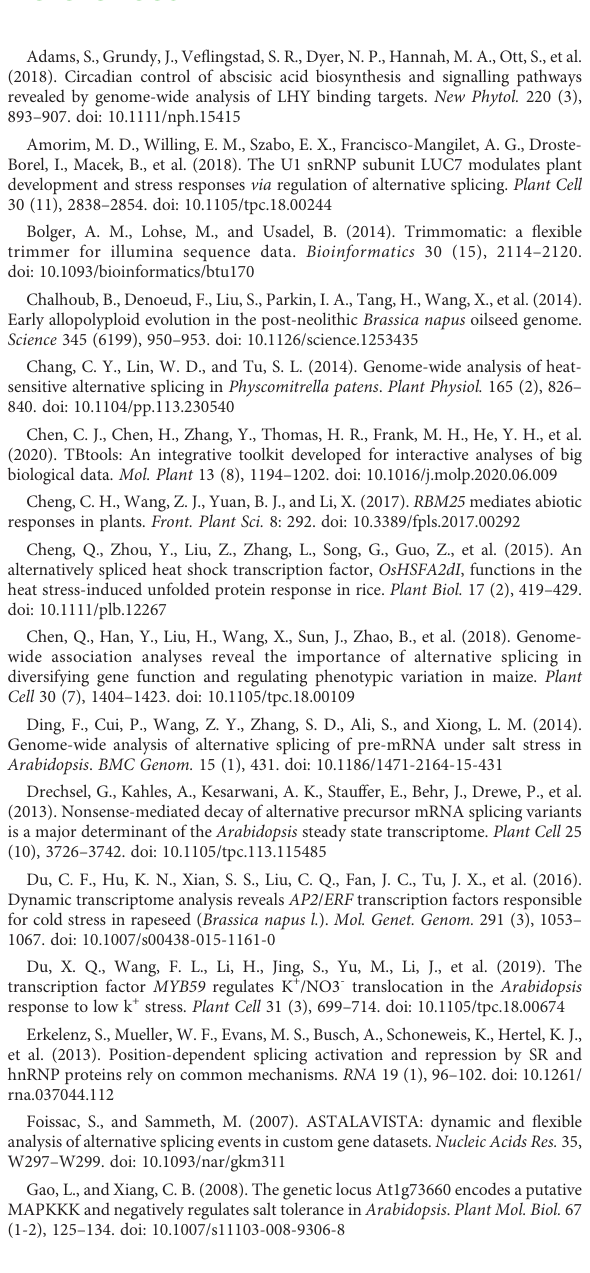
Top20 GO terms enrichment of genes in the seven stress-related modules. (A-G) respectively represented brown, turquoise, green, pink, blue, magenta, and yellow module. The x-axis represented the -log10 (Pvalue) which shows the signi fi cant level. The size of the bubble represented the enriched gene number. SUPPLEMENTARY FIGURE 4 Quantitative visualization (sashimiplot) and transcripts structures of the DAS gene (MSTRG.1012, RBP) under multiple abiotic stresses. (A-C) represented dehydration, ABA and NaCl stress, respectively. The